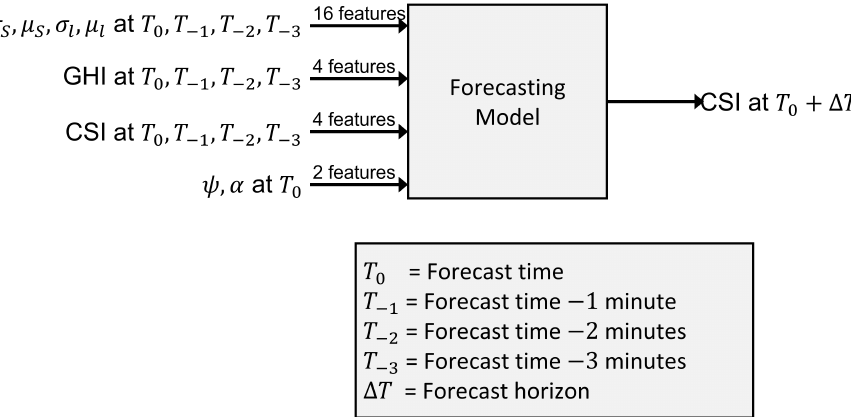
Figure 6. Prediction scheme for all the proposed